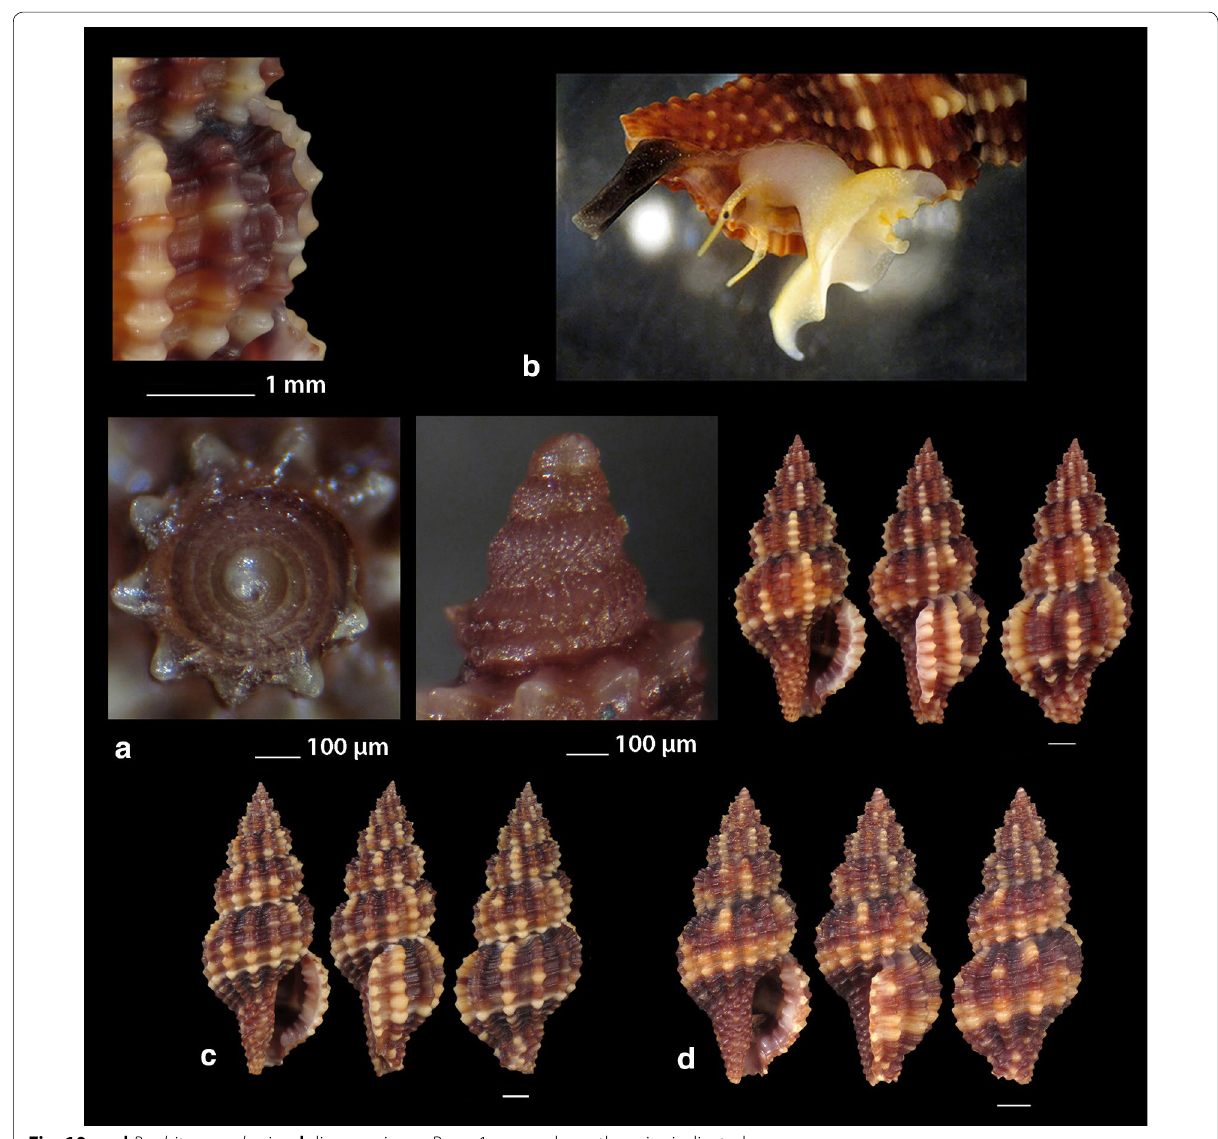
Fig. 10 a – d Raphitoma ephesina , b live specimen. Bar